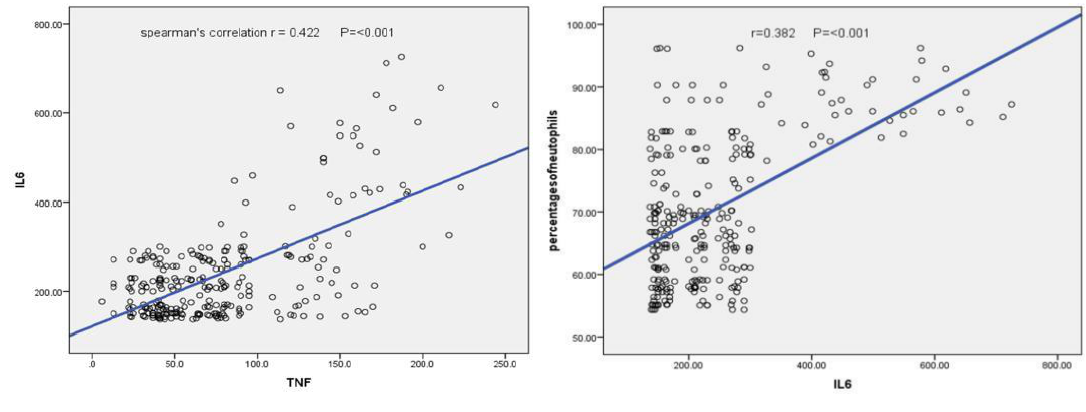
Figure 4. a): Correlation of IL-6 with TNF-α serum levels and, b) Correlation of IL-6 with neutrophil blood counts in COVID-19 patients with different